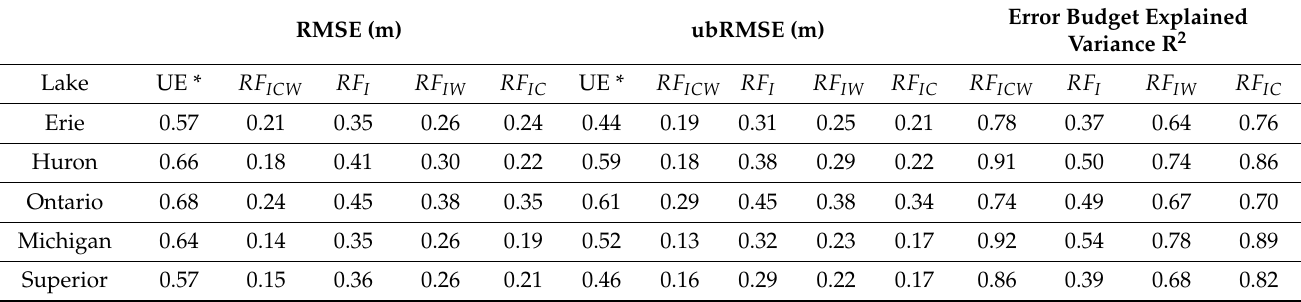
UE * represents the uncorrected GEDI water level